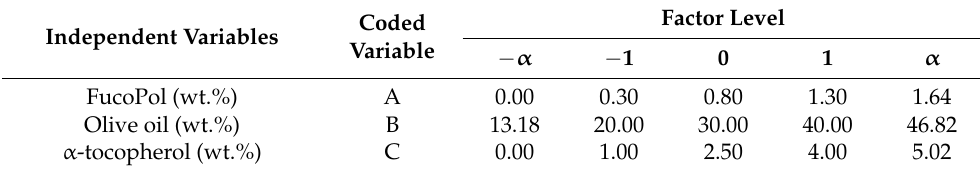
Table 1. Independent variables and their levels used in the response surface design. Independent